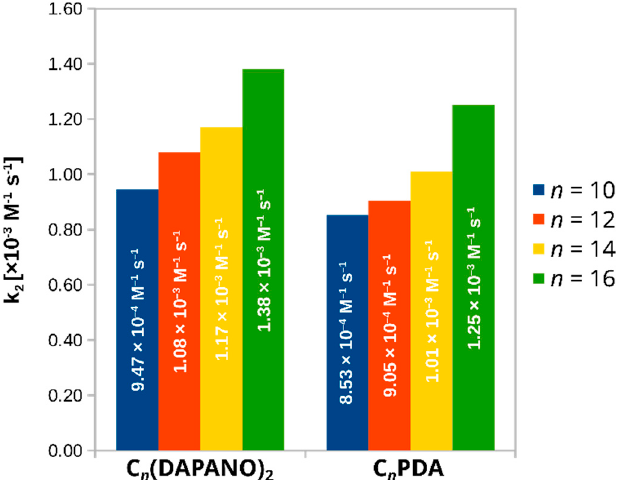
Figure 6. Comparison of the second-order rate constants k 2 for the reaction between the N-oxide surfactants and DPPH•. surfactants and DPPH •